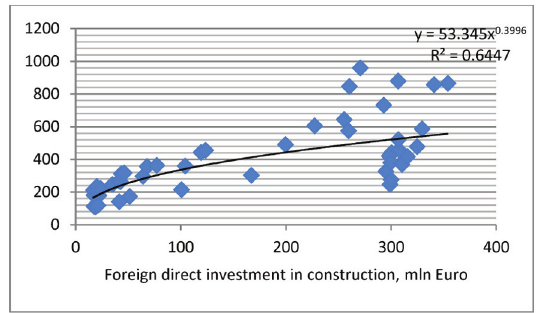
Fig. 1. The correlation between foreign direct investment in con- struction and value added by the Lithuanian construction sector Table 1. Estimation results of the relationship between CFDI and the construction’s contribution to GDP Significance of the correlation Correlation Variables coefficient, r